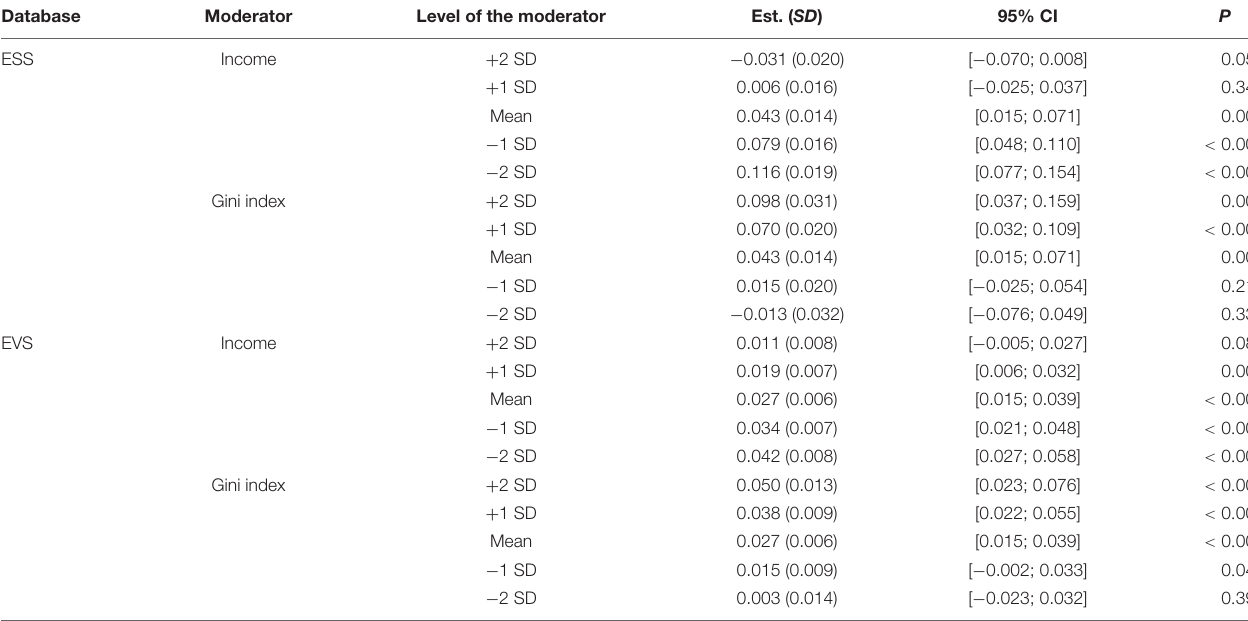
TABLE 3 | Result of simple slope analyses predicting subjective well-being at different levels of income and Gini indices.